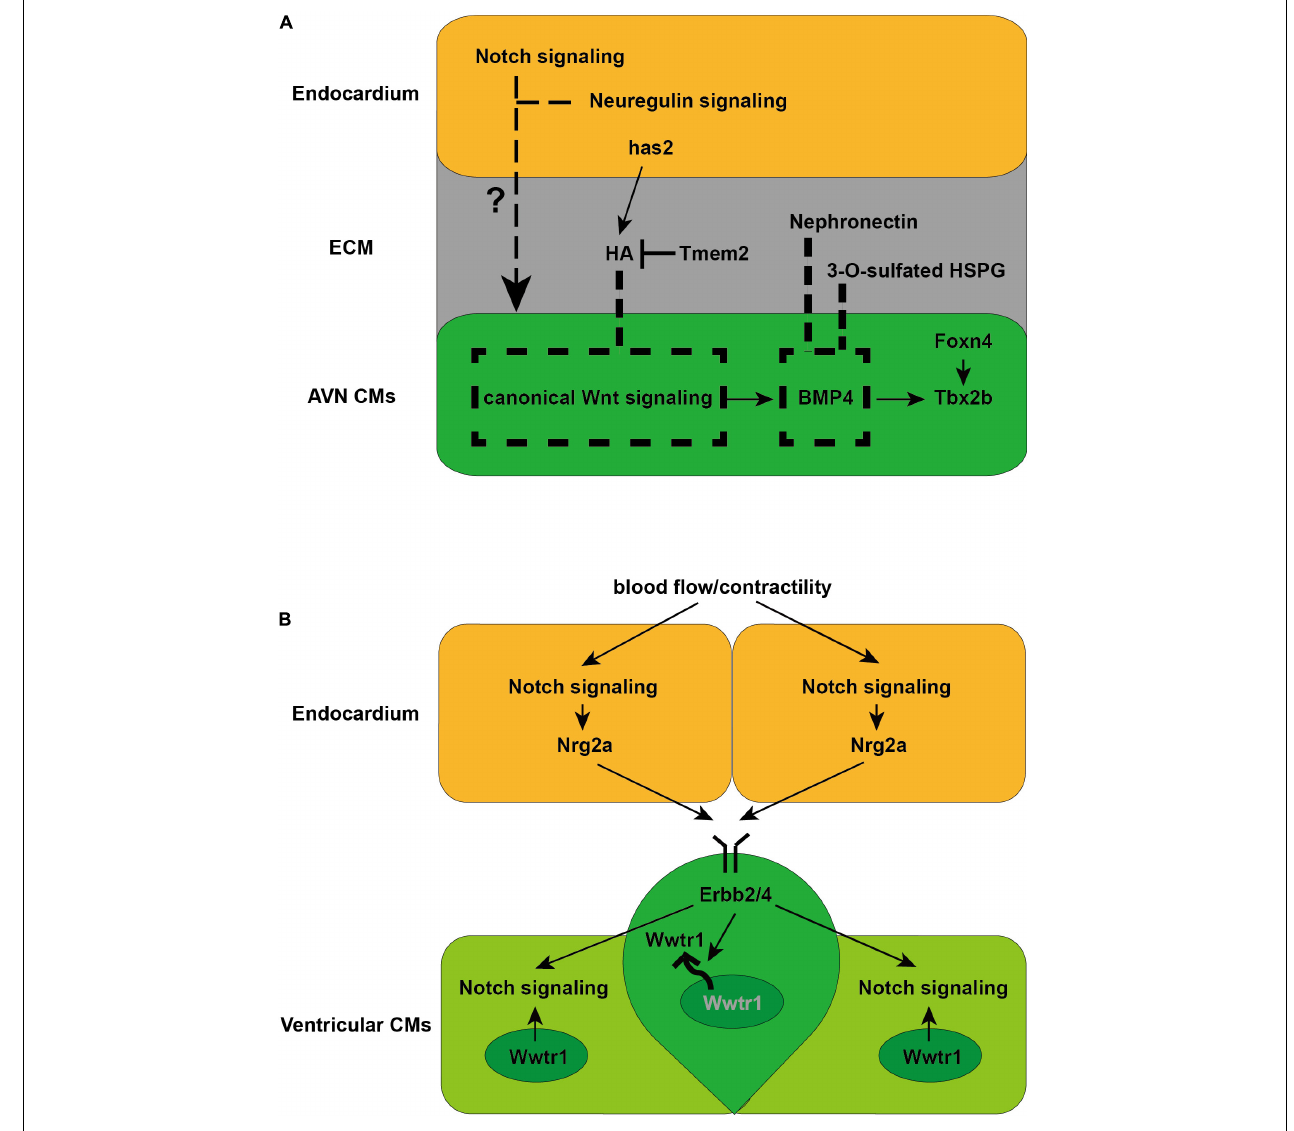
FIGURE 2 | Schematics illustrate the cellular and molecular mechanisms directing AVN and trabeculae CM formation discovered in zebrafish. (A) Endocardial Notch and neuregulin signaling are required for AVN CM formation (Milan et al., 2006). Meanwhile canonical Wnt signaling is crucial for AVN CM formation by activating myocardial BMP4 and Tbx2b expression (Verhoeven et al., 2011). ECM-related factors, including HA, Nephronectin and 3-O-sulfated HSPG, limit the distribution of canonical Wnt signaling or BMP4 to confine AVN CM differentiation within the AVC (Patra et al., 2011; Samson et al., 2013; Hernandez et al., 2019). (B) Endocardial Notch signaling and Nrg2a is activated by blood flow/contractility, which is received by Erbb2/4 receptor in the CMs to induce trabeculation (Liu et al., 2010; Peshkovsky et al., 2011; Staudt et al., 2014; Samsa et al., 2015; Rasouli and Stainier, 2017). Erbb2 signaling further activates Notch signaling in the neighboring CMs, which acts cell autonomously to inhibits Erbb2 signaling to establish the compact wall architecture necessary for trabeculation (Han et al., 2016). Erbb2 signaling also preserves the architecture of the compact wall by regulating the nuclear localization of Wwtr1, a Hippo pathway effector (Lai et al.,